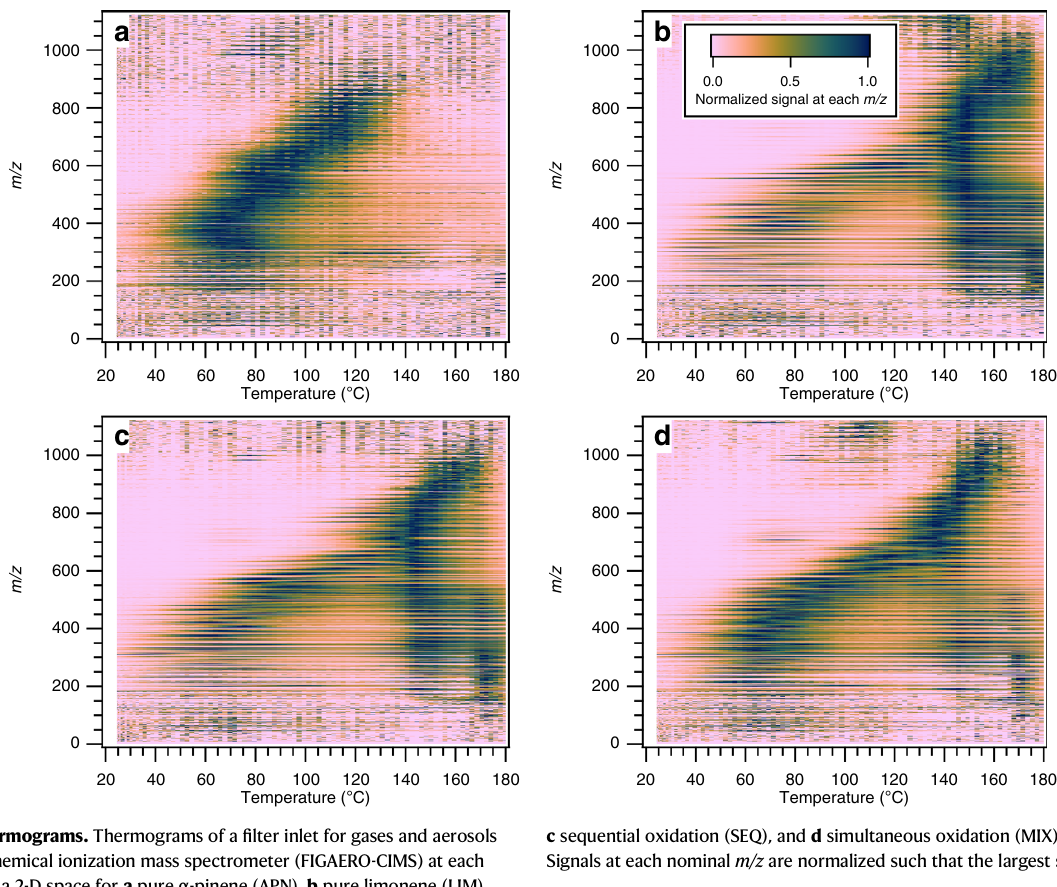
Fig. 5 | 2-D thermograms. Thermograms of a fi lter inlet for gases and aerosols coupled to a chemical ionization mass spectrometer (FIGAERO-CIMS) at each nominal m/z in a 2-D space for a pure α -pinene (APN), b pure limonene (LIM),